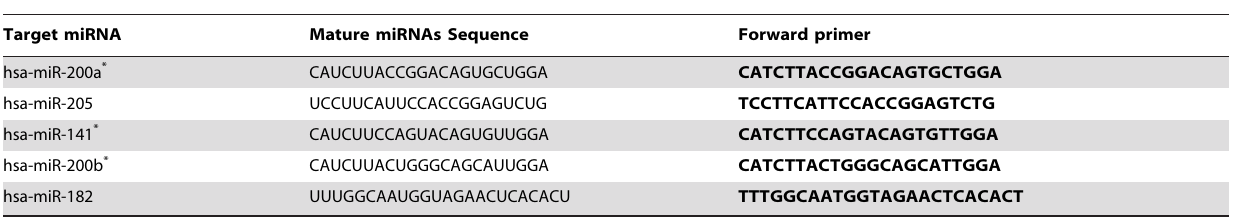
Table 1. PCR primers for miRNAs.